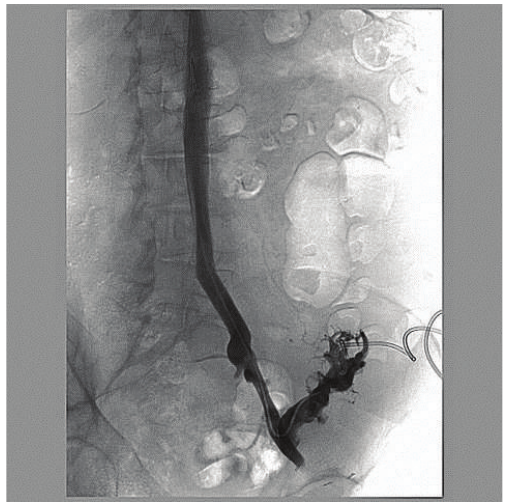
Figure 5: Follow-up venogram demonstrating widely patent iliac vein, stent, and transplant allograft